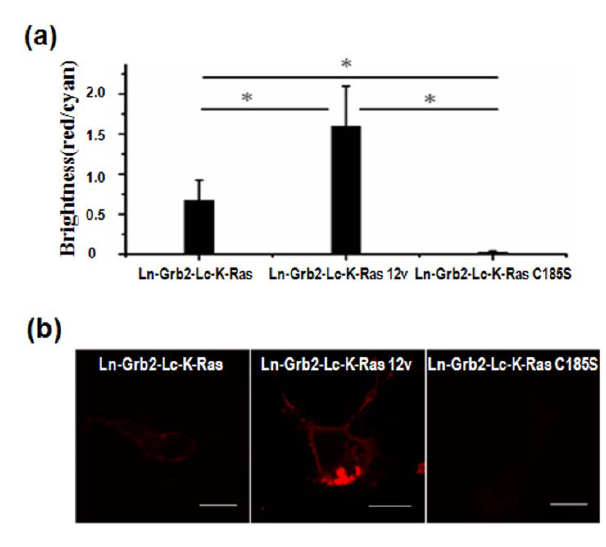
Figure 3. BiFC assays of interaction between K-Ras and Grb2. ( a ) BiFC efficiency analysis and ( b ) confocal imaging of cells cotransfected with pBud-Ln-Grb2-Lc-K-Ras (K-Ras 12v or K-Ras C185S) and pmCerulean-C1. Scale bar = 20 μ